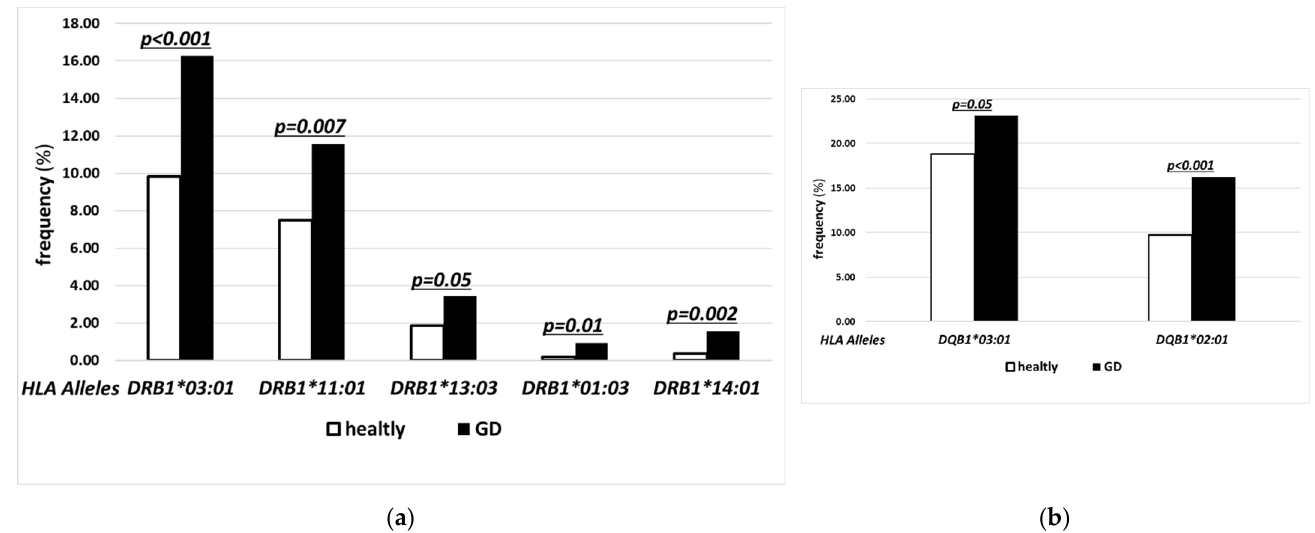
Figure 2. Frequencies (%) of human leukocyte antigen (HLA_ over-represented alleles with statisti- cally significant difference between control (open bars) and Graves’ disease (GD) patients (solid bars) for major histocompatibility complex (MHC) class II alleles: HLA-DRB1 ( a ) and HLA-DQB1 ( b ).